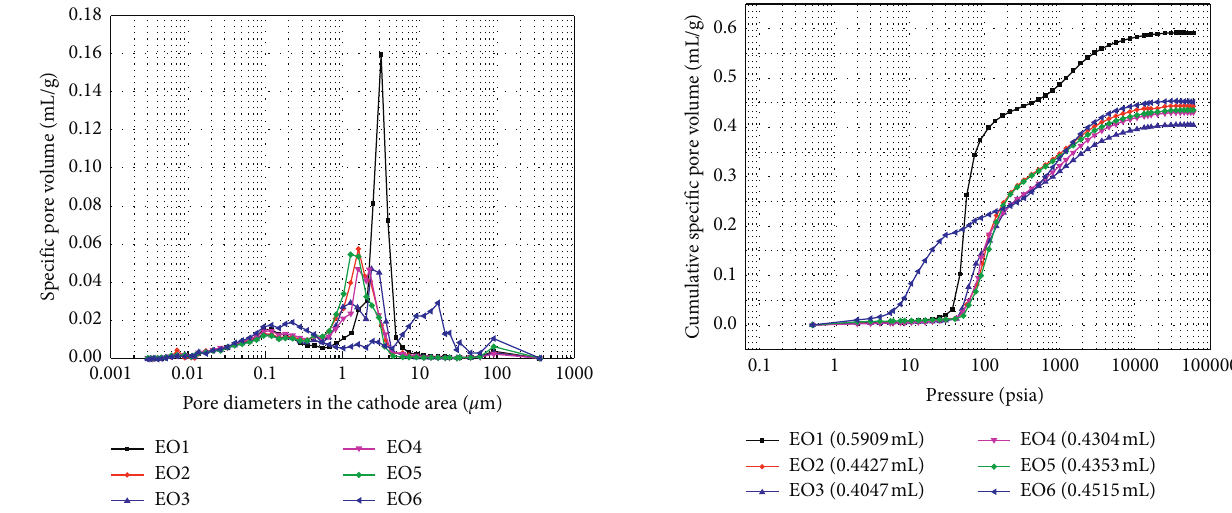
Figure 10: Pore diameters in the cathode area. Figure 11: Total pore volume in cathode soils.